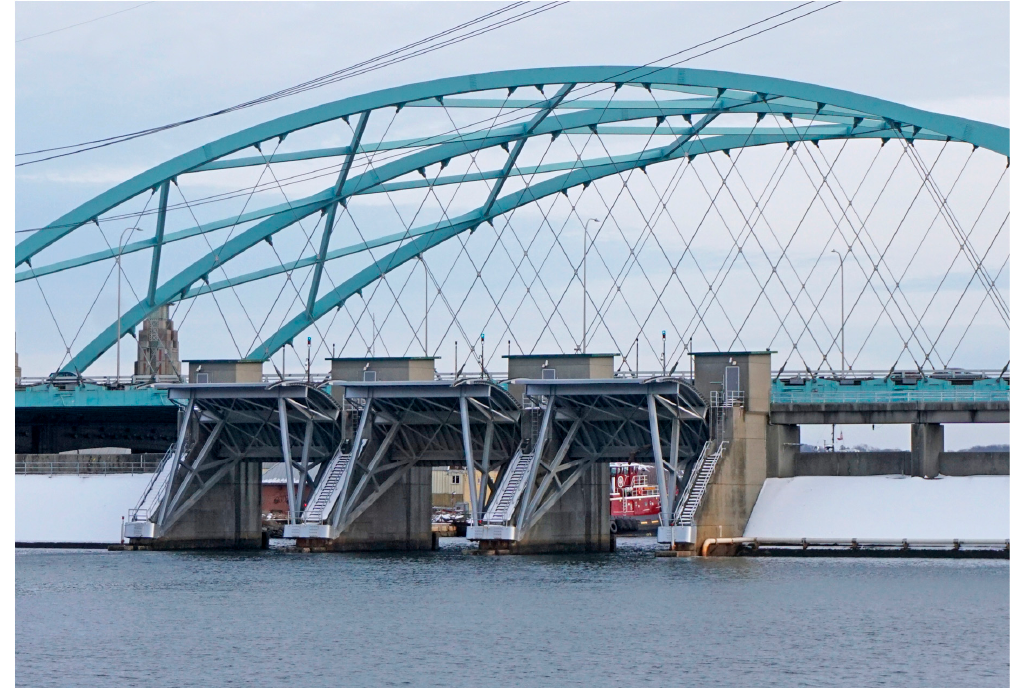
Figure 2. The Fox Point Hurricane Barrier (FPHB) in Providence, RI (photo is courtesy of The Providence Journal).